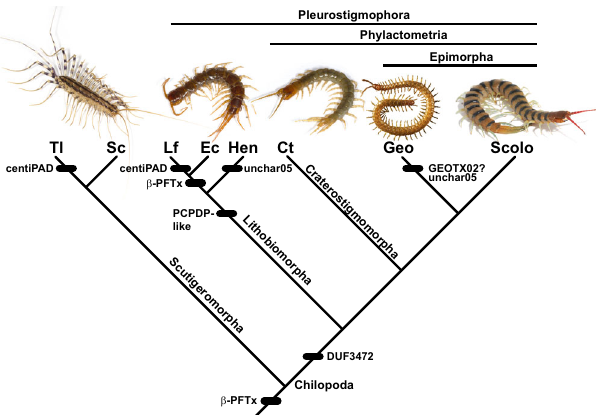
Fig. 6 Phylogenetic distribution of centipede venom gene families horizontally transferred from bacteria and fungi. ‘ ? ’ indicates uncertainty in the direction of transfer. Taxon abbreviations are as follows. Tl: Thereuopoda longicornis ; Sc: Scutigera coleoptrata ; Lf: Lithobius for fi catus ; Ec: Eupolybothrus cavernicolus ; Hen: Henicopidae; Ct: Craterostigmus tasmanianus ; Geo: Geophilomorpha; Scolo: